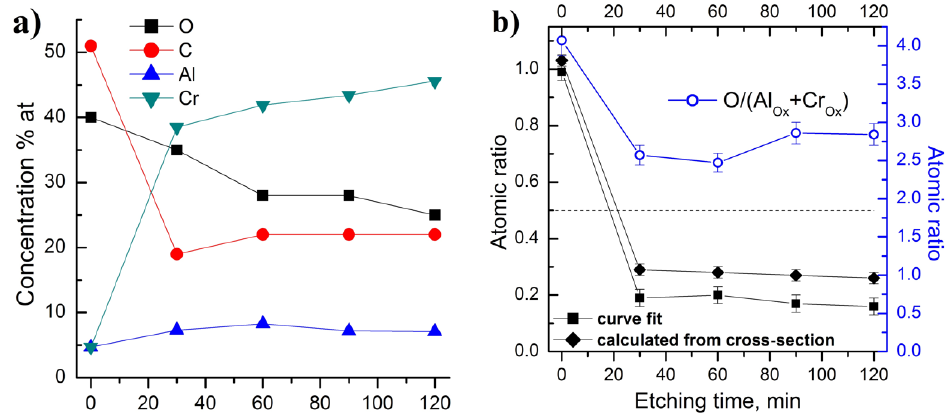
Figure 3. ( a ) Atomic composition at the surface; ( b ) O/(Al Ox + Cr Ox ) and Al/Cr atomic ratios for Cr-Al-C coating at 90 V as a function of Ar + etching time obtained two different ways.